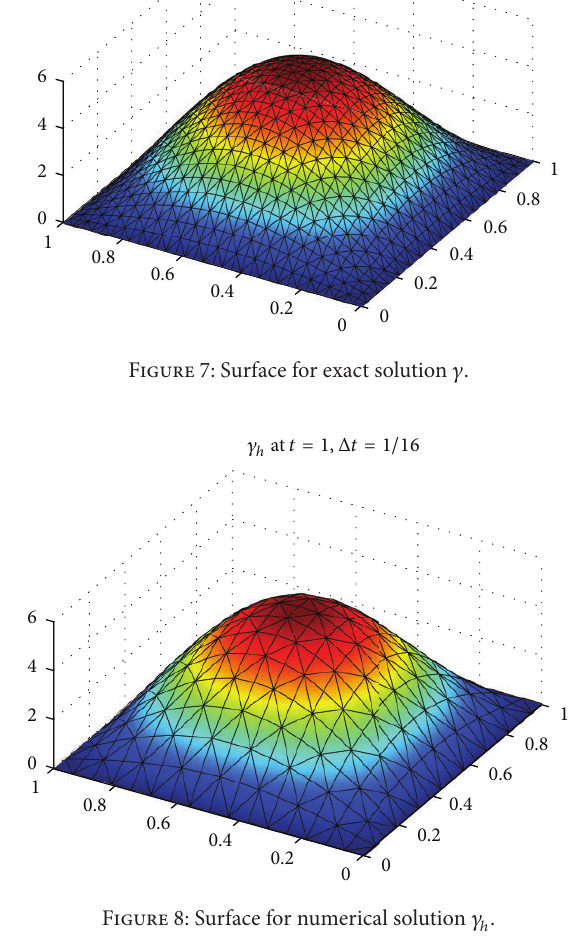
Figure 8: Surface for numerical solution 𝛾 ℎ